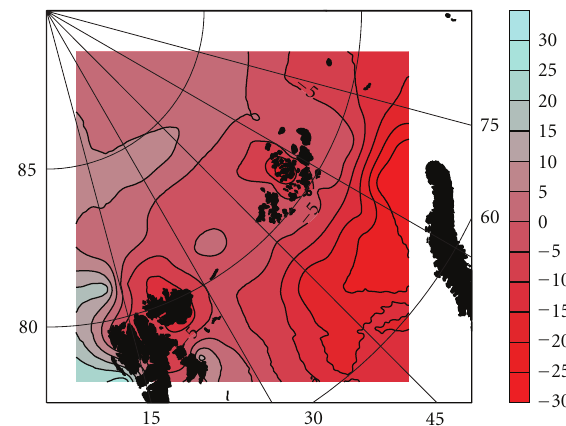
Figure 12: Averaged 1980–2010 winter distribution of sensible heat flux at the surface, W/m 2 (a); di ff erence in heat flux between 1999– 2010 and 1980–1995